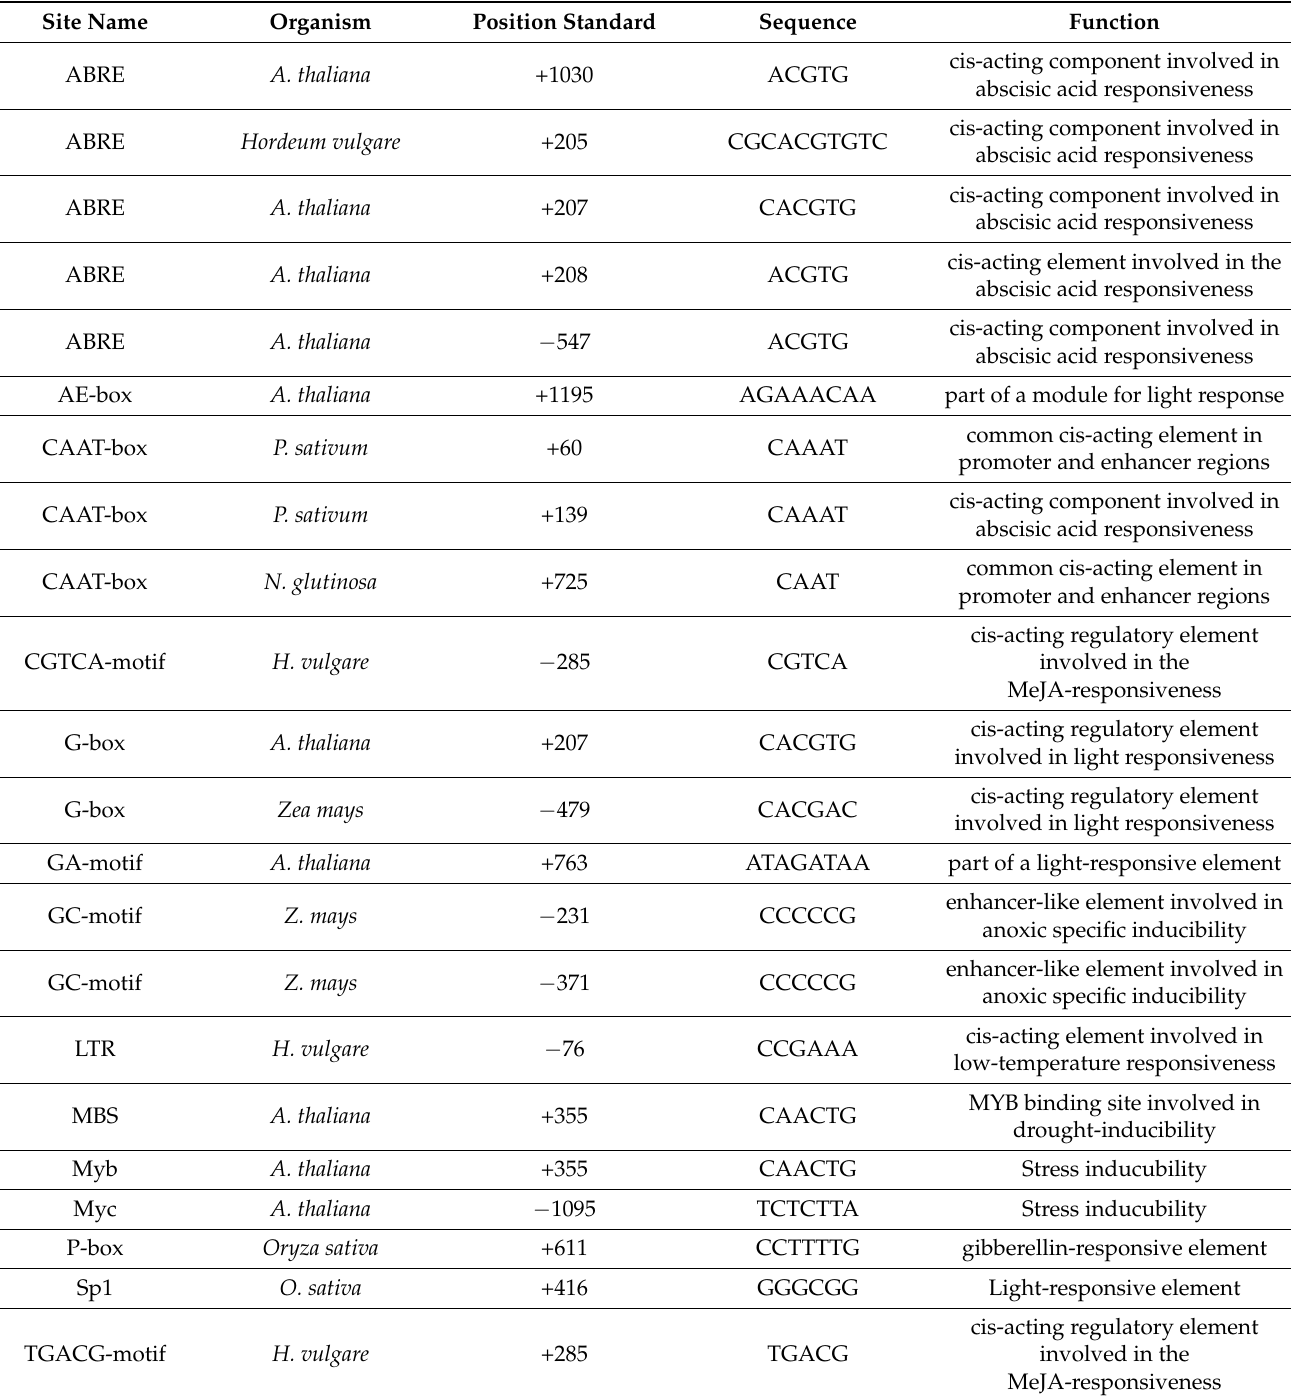
Table 2. Site name, position, sequence and function of primers of